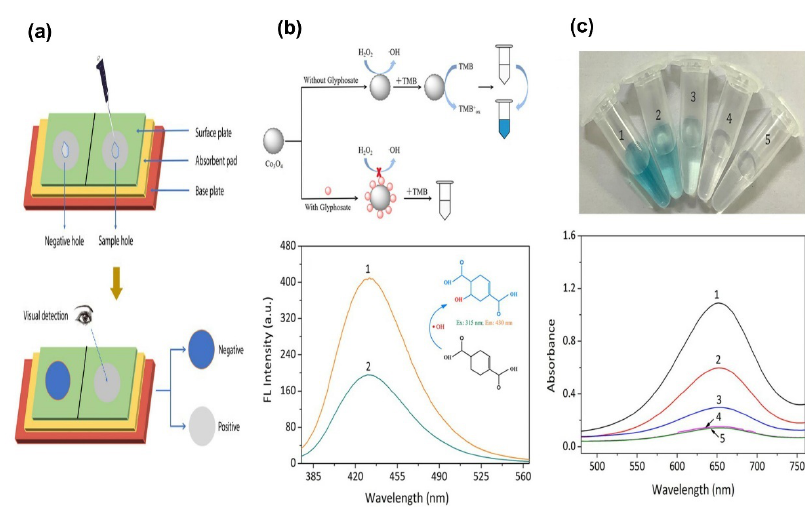
Figure 13. Detection of GLYP by Co 3 O 4 nanoplates on a polyester membrane. ( a ) Representation of the inhibitory effect of GLYP on the peroxidase activity of nanoplates; ( b ) Fluorescence spectra in solution of the TMB reaction product in the presence and absence of GLYP; ( c ) Colorimetric signal changes of colorimetric nanozyme sheets without (sample 1) and with GLYP (sample 2); sample 3 and 4 are control assays without nanozyme. Reprinted with permission from [147]. Copyright 2021 ACS Publications.